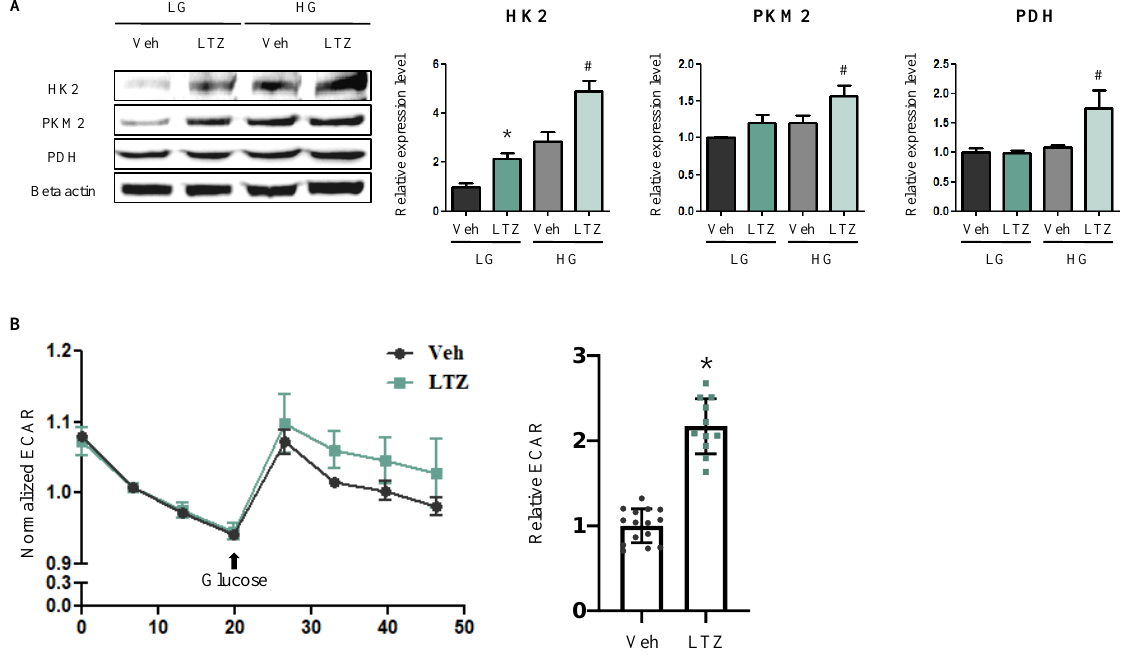
Figure 5. Letrozole directly increases the amount of glucose consumption in cardiomyocytes. ( A ) To evaluate whether glucose is consumed independent of letrozole role in modulating estrogens levels, we performed a glucose-addition assay with H9c2 cells treated with letrozole. Low glucose con- centration (LG) and high glucose concentration (HG) contained 1000 mg/L and 4500 mg/L from D-glucose respectively. The levels of proteins related to glycolysis were determined via Western blotting. Beta actin was used as internal control. ( B ) To prove whether letrozole directly promotes glucose consumption, we performed a glycolysis stress test with H9c2 cells treated with letrozole. Extracellular acidification rate (ECAR) was measured quantitatively using a Seahorse XFp analyzer. The values stand for means ± S.D. * p < 0.05 compared to LG-Veh-cells or Veh-cells. # p < 0.05 compared to